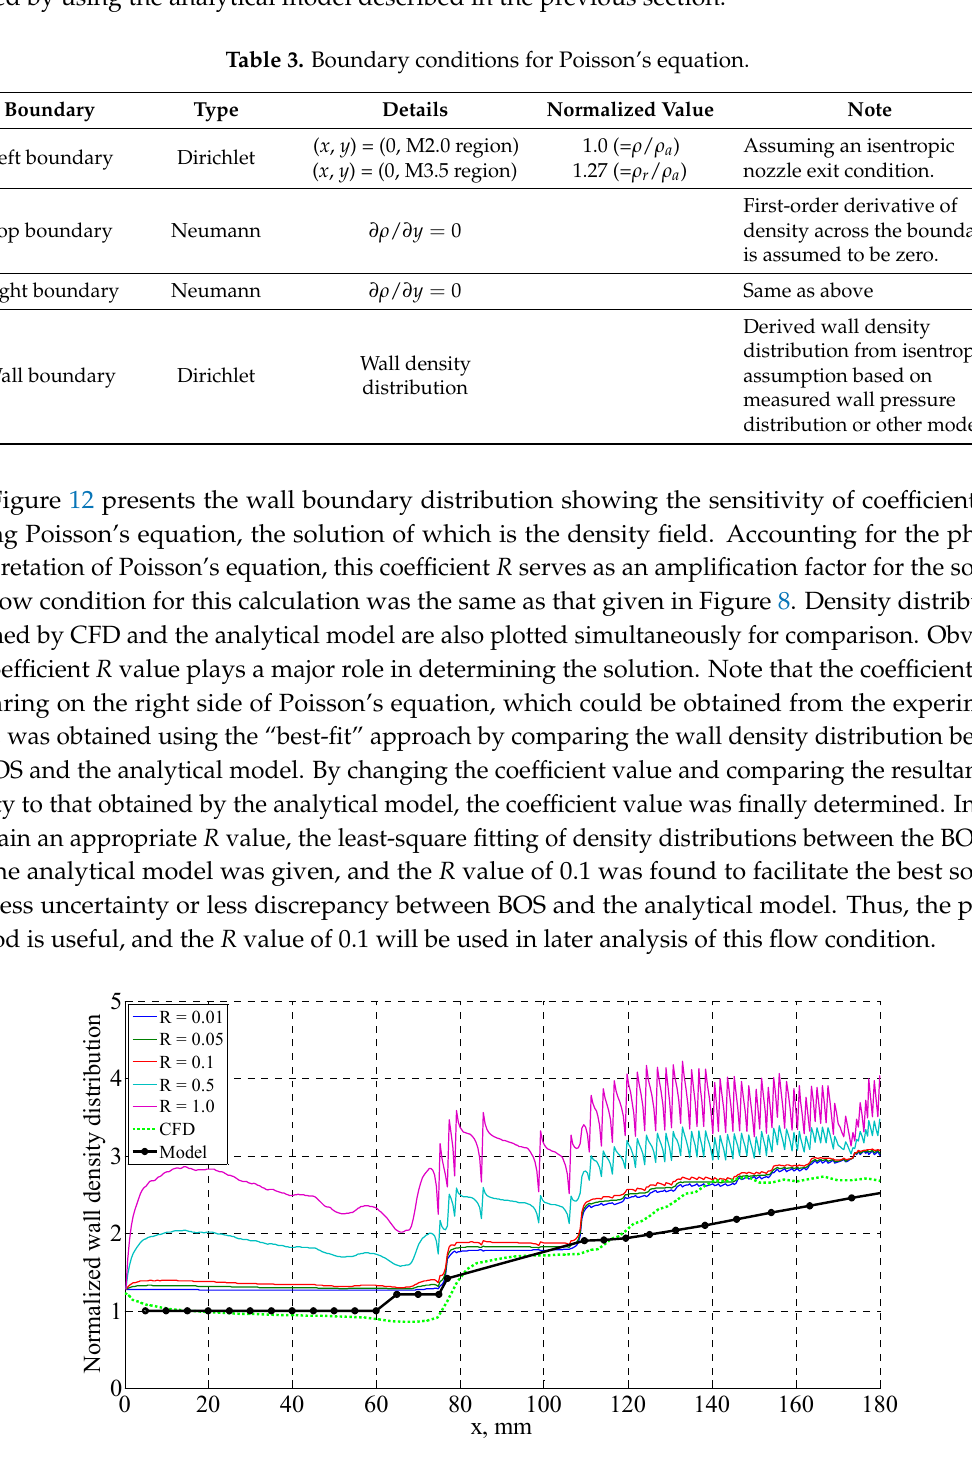
Figure 12. Sensitivity of R on the density calculation by solving Poisson’s equation.